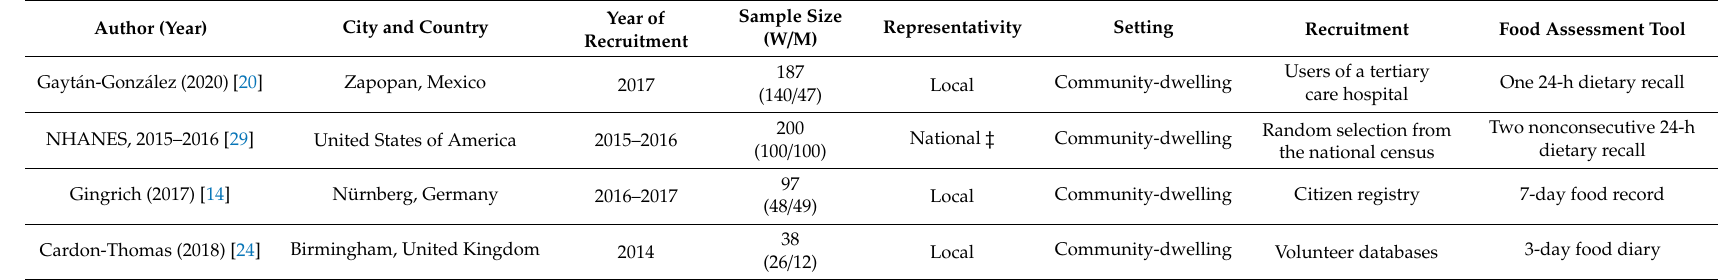
Table 1. Description of studies’ main